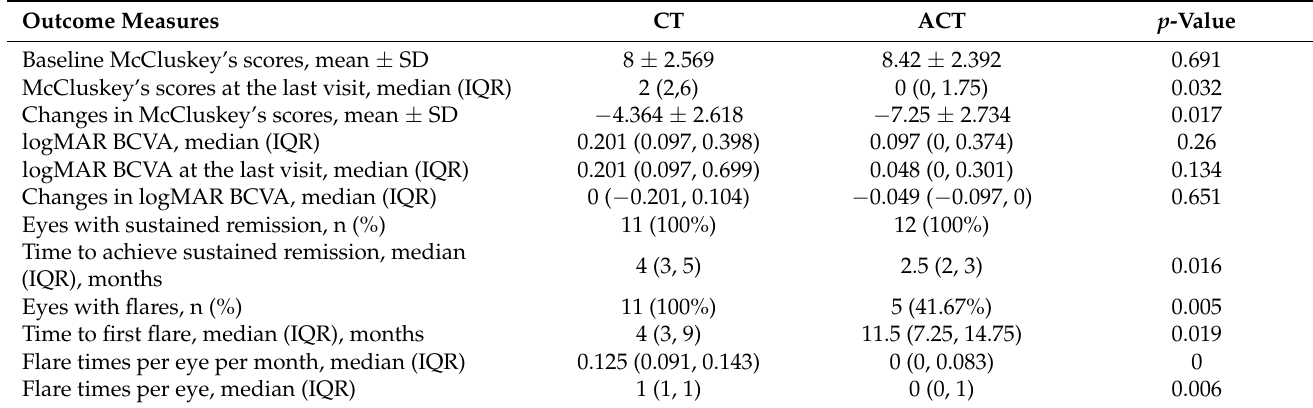
Table 2. The parameters of